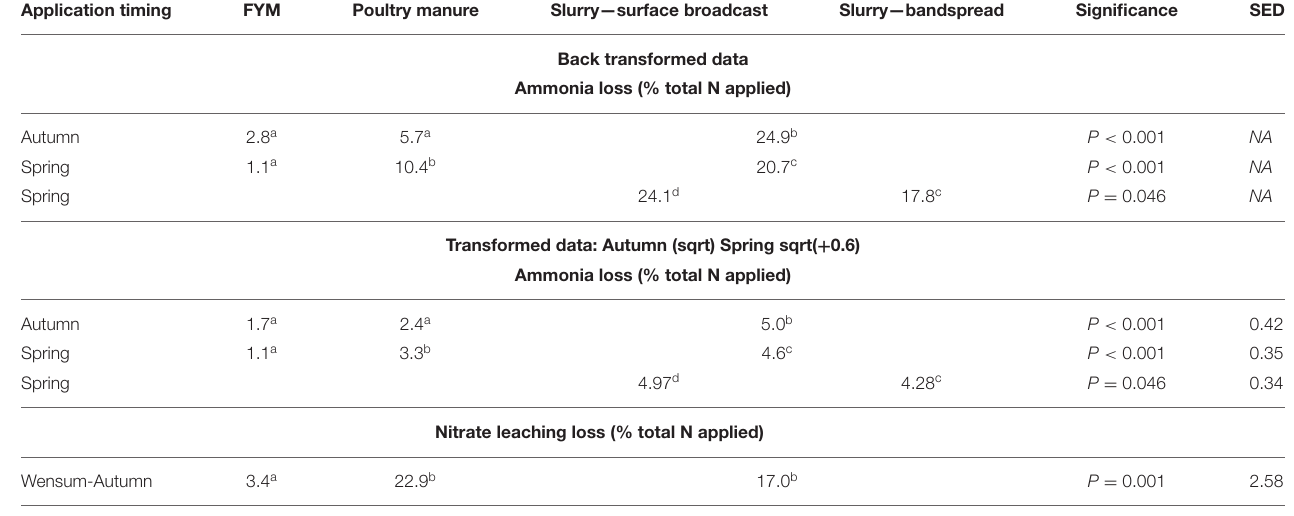
TABLE 7 | Ammonia losses from the autumn and spring manure applications at all sites, and nitrate leaching losses following autumn manure applications at Wensum. Application